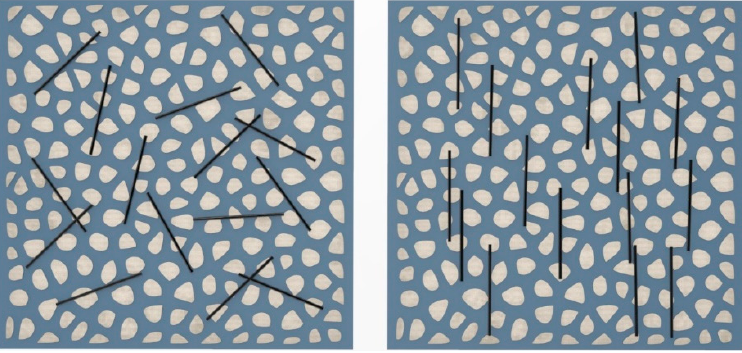
Figure 15. Vertically aligned steel fibers owing to magnetic field in container 2.